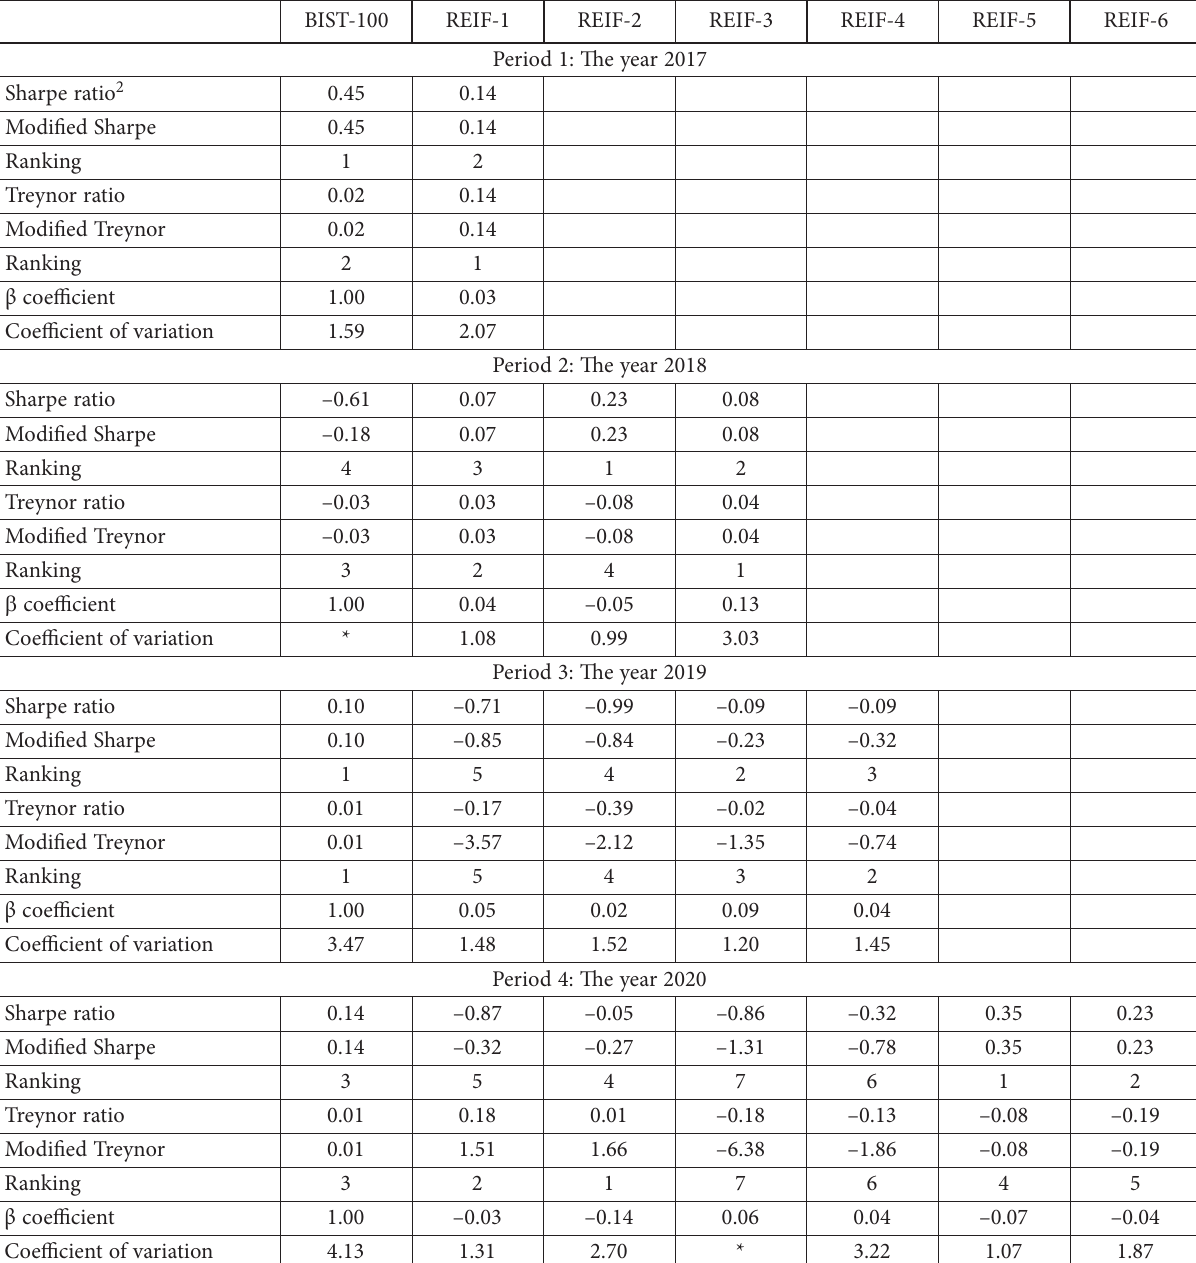
Table 2. Comparison of REIFs’ and BIST 100’s performances for different